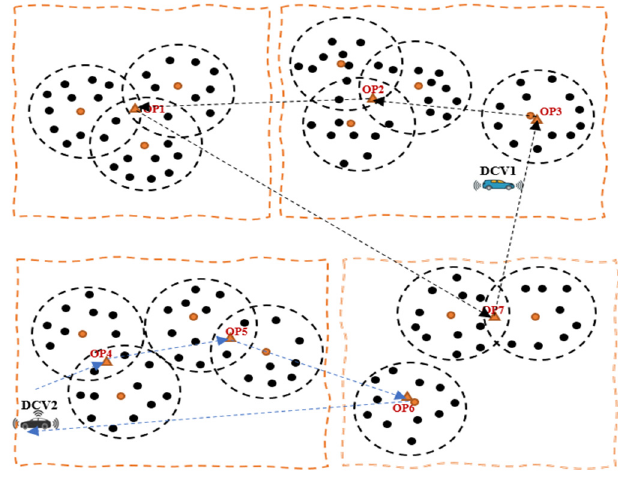
Figure 6. Optimal point selection and path computation with multiple DCVs.